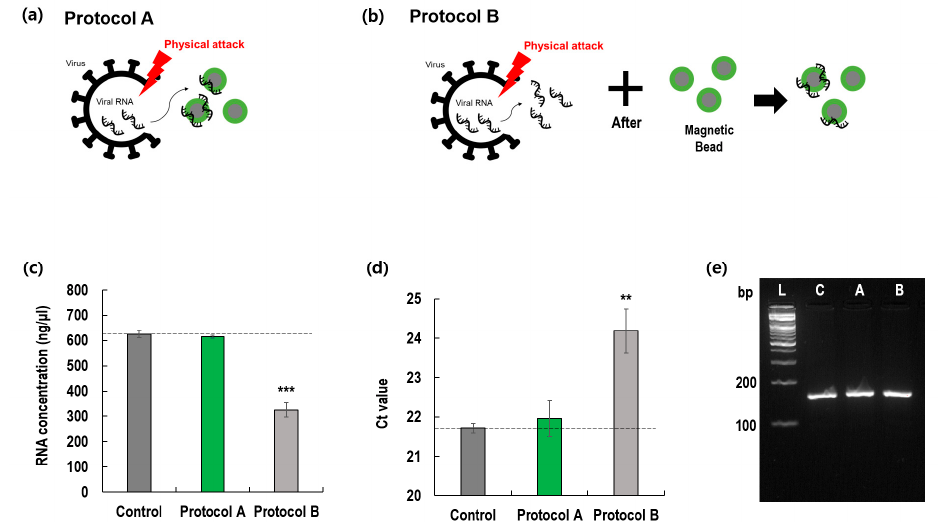
Figure 4. Comparison of two protocols (A and B). ( a ) Protocol A; ( b ) Protocol B; ( c ) Extracted RNA concentrations; ( d ) Threshold cycles of PCR for extracted RNA; ( e ) Gel electrophoresis of amplified RNA (** p < 0.005; *** p < 0.001) (L: DNA ladder, C: QIAamp, A: Protocol A, B: Protocol B).